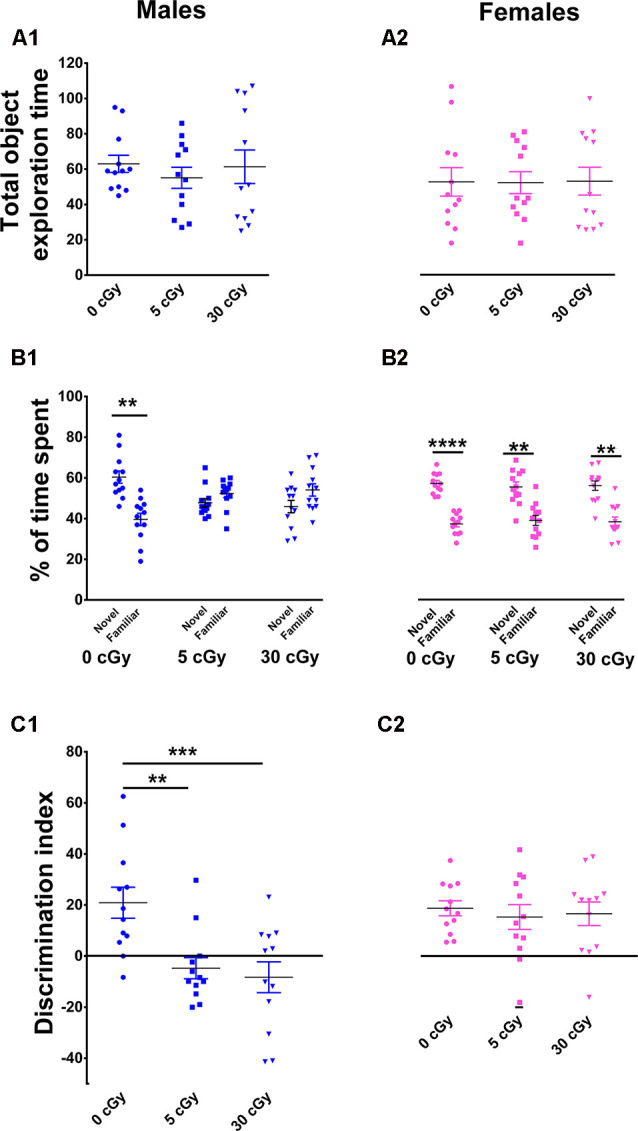
Object in place memory is impaired in male but not female mice after 4He irradiation. During the Object-in-Place (OiP) task, total exploration times were comparable between controls and irradiated cohorts (A1,A2). Preference for novelty was reduced significantly following irradiation in male mice (B1), but not in female mice (B2). Two-way ANOVA revealed a significant sex × radiation interaction (p = 0.03), a significant radiation effect (p = 0.0001), and a significant sex effect (p = 0.04). Post hoc analysis showed that DI was significant reduced in male mice following irradiation, but not in female mice (C1,C2). As opposed to males, irradiated female mice showed no signs of cognitive impairment. Individual animals represented as dots; lines depict group means and SEM. N = 12 for each experimental group. **p < 0.01, ***p < 0.001, ****p < 0.0001.